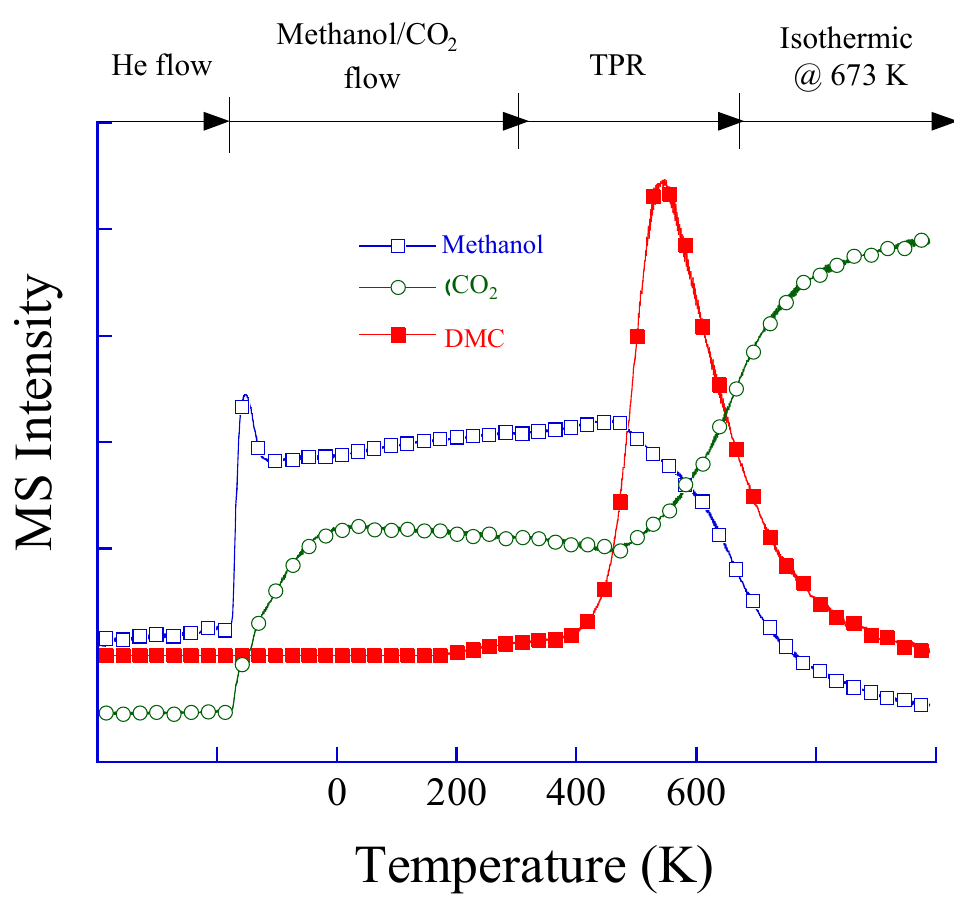
Figure 3- MS intensity during the methanol/CO 2 TPR over Rh/Al 2 O 3. Figure 3. MS intensity during the methanol/CO 2 TPR over Rh/Al 2 O 3. The dynamics of IR spectra of reaction ingredients during the flow of methanol/CO 2 over Rh/Al 2 O 3 catalyst at 373 K are shown in Figure 5. The initial IR spectrum at 0.5 min produces bands at 1589 and 1461 cm − 1 . After 5 min of exposure to methanol/CO 2 , the intensity of the C–H stretching bands at 2964 and 2845 cm − 1 increased, together with the intensities of linear and bridge CO at 2029 and 1873 cm − 1 , respectively. At the same time, weak bands appeared at 1772 cm − 1 , which can be assigned to gaseous DMC. The observed dynamics of IR spectrum are probably due to the change of state of Rh, particularly reduction of